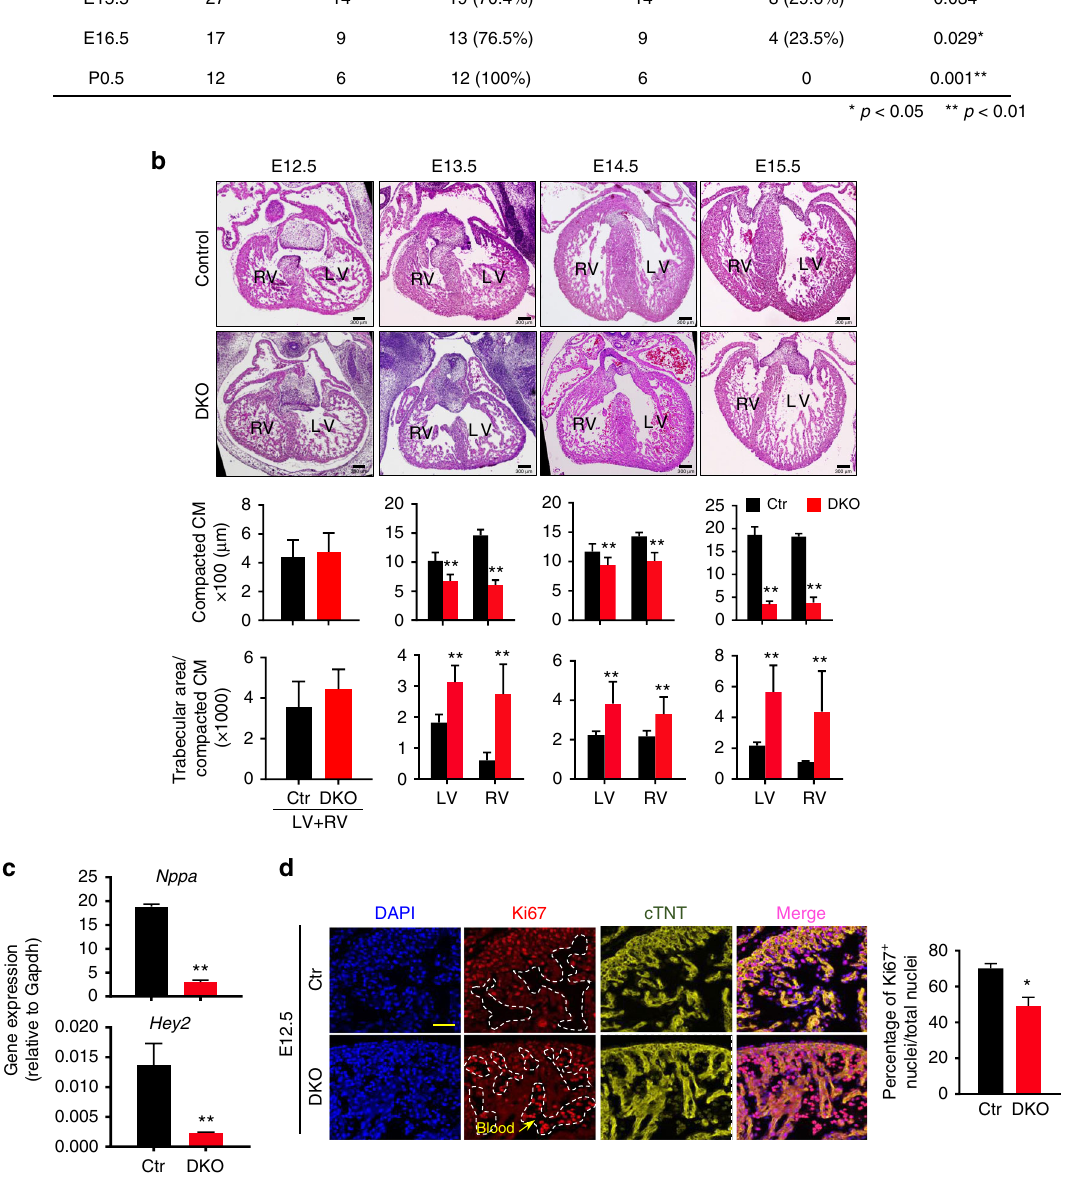
(scRNA-seq) on control and Tet2/3-DKO E12.5 and E15.5 hearts (Supplementary Table 1 and 3). Consistent with our histological analysis data (Fig. 2c), we observed minor differences in the cell types in E12.5 hearts between control and Tet2/3-DKO embryos. However, we noticed a massive reduction of the CMs (from 32.9% to 6.8%) in the Tet2/3-DKO group at E15.5 (Fig. 3d, Supplementary Fig. 4F-G). Furthermore, consistent with our real- time qPCR analysis and bulk RNA-seq data described above (Figs 2d and 3a), key genes involved in ventricular compaction, NATURE COMMUNICATIONS| (2019) 10:4297